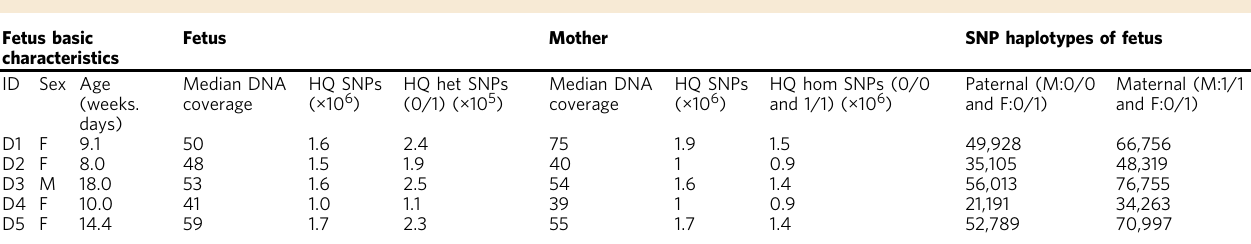
Table 1 Basic characteristics of the fetal material used in the study Fetus basic Fetus Mother SNP haplotypes of fetus characteristics ID Sex Age